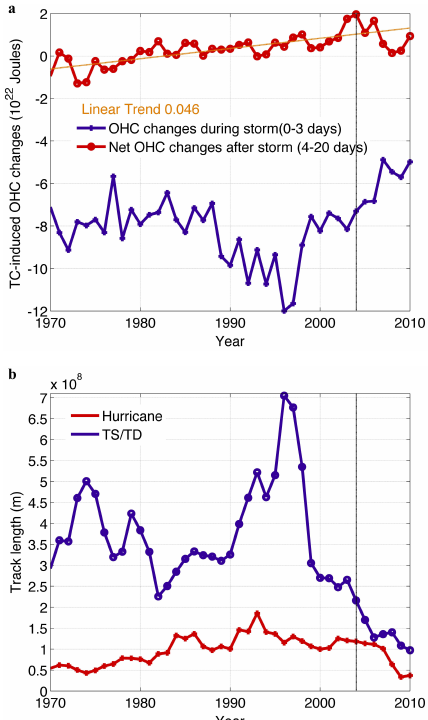
Figure 16. (a) : the annual TC-induced ocean heat loss via air–sea heat flux in 0–3 days (blue line) and the ocean heat content changes after storms (in 4–20 days) (red line). The positive values show the ocean heat gain. The linear trend of the ocean heat gain is presented in pink, and the trend is 0.046 × 10 22 Jyr − 1 . (b) : yearly averaged track lengths for both TS/TD (blue) and hurricanes (in